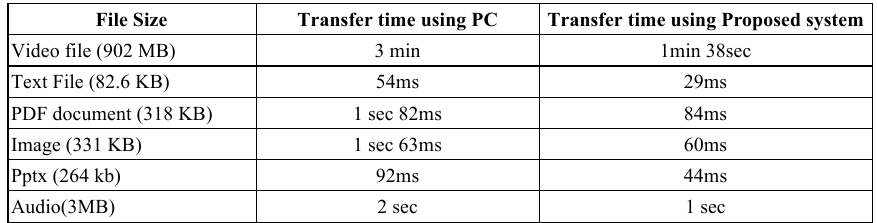
Table 1. Data Transfer Seed using pc and the proposed system